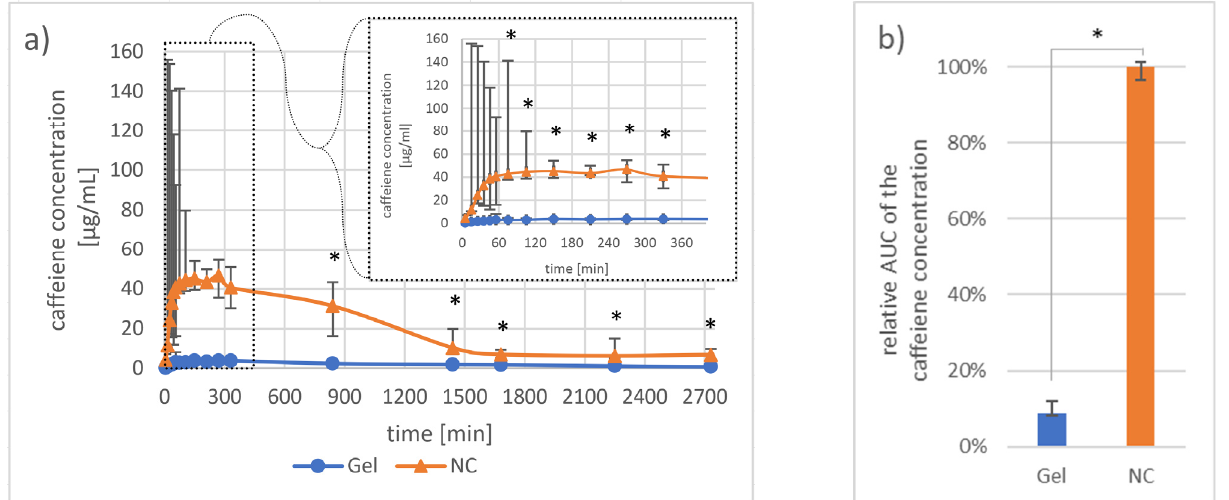
Figure 4. Graph ( a ) presents the median ± one quartile caffeine concentration sampled by microdialysis from the two investigated areas on porcine ear skin compared at different time points. Graph ( b ) shows the median ± one quartile area under the curve from the obtained caffeine concentration data. The gel- and the nanocrystal gel formulation (NC) were compared in both graphs. Differences between the two areas of p < 0.05 were considered significant (*). n = 5.